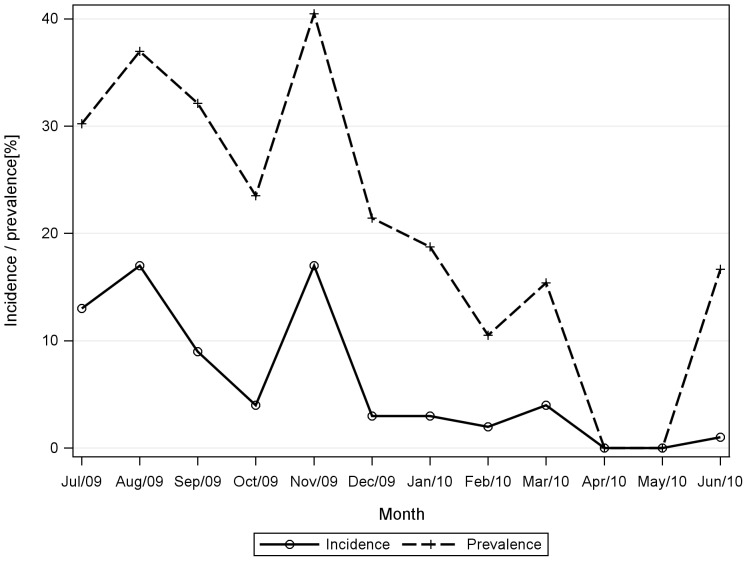
Seasonal distribution of HPeV-positive samples.Incidence means HPeV positive cases per month, prevalence means HPeV positive rate per month.